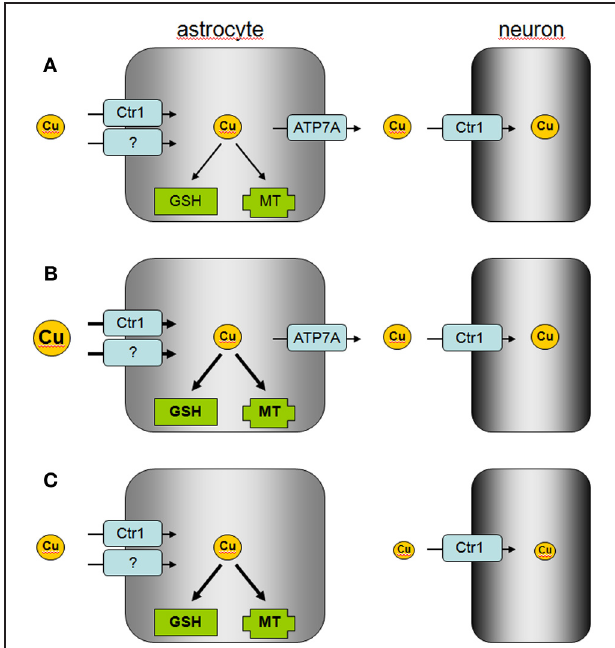
FIGURE 2 | Proposed model of astrocytic copper supply to neurons. (A) In the normal brain, copper is efficiently taken up by astrocytes via Ctr1 and other transporters which are so far not identified. Excess of copper is stored by astrocytes in MT or as GSH complex and copper is released via ATP7A to supply neurons with copper. (B) In copper overload conditions, excess of copper is efficiently taken up into astrocytes and stored in MT or as GSH complex to prevent copper-induced neurotoxicity. (C) In Menkes disease, astrocytes accumulate and store copper, but the mutated ATP7A is unable to mediate astrocytic copper export and copper supply to